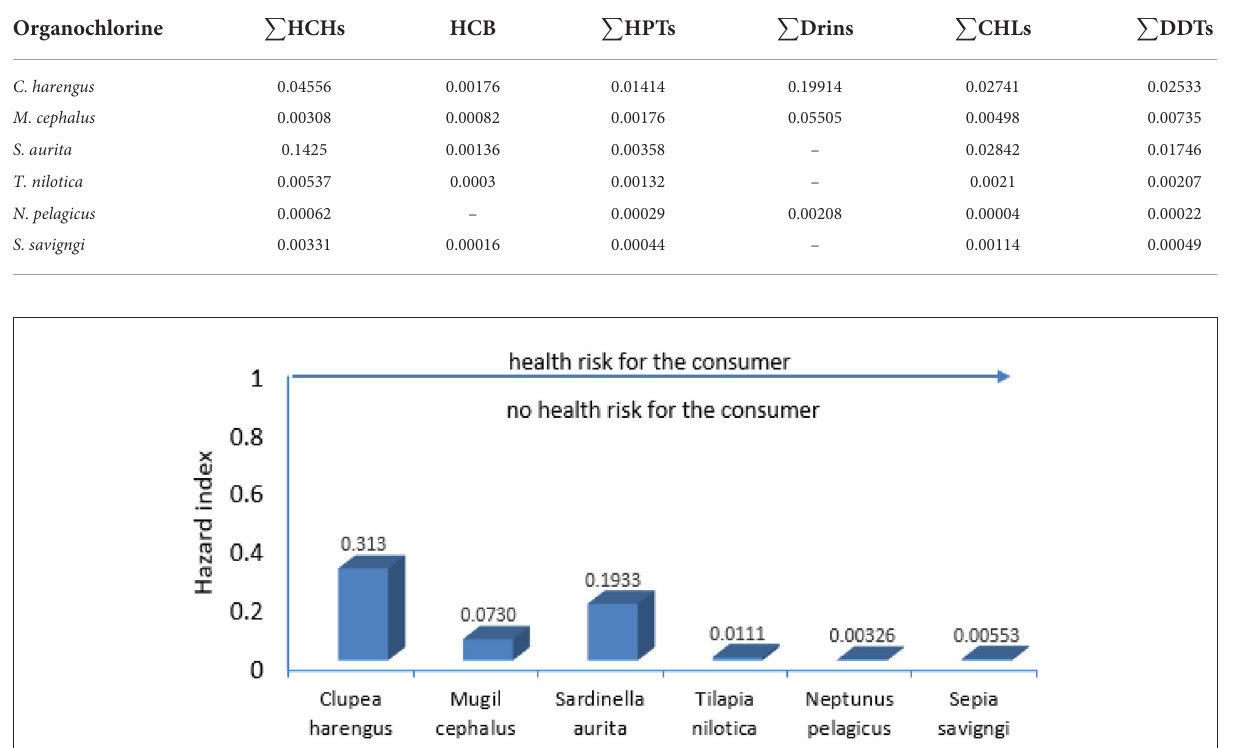
TABLE 5 Target hazard quotient (THQ) of organochlorine pesticides for Mansoura citizens, Egypt, due to seafood consumption.